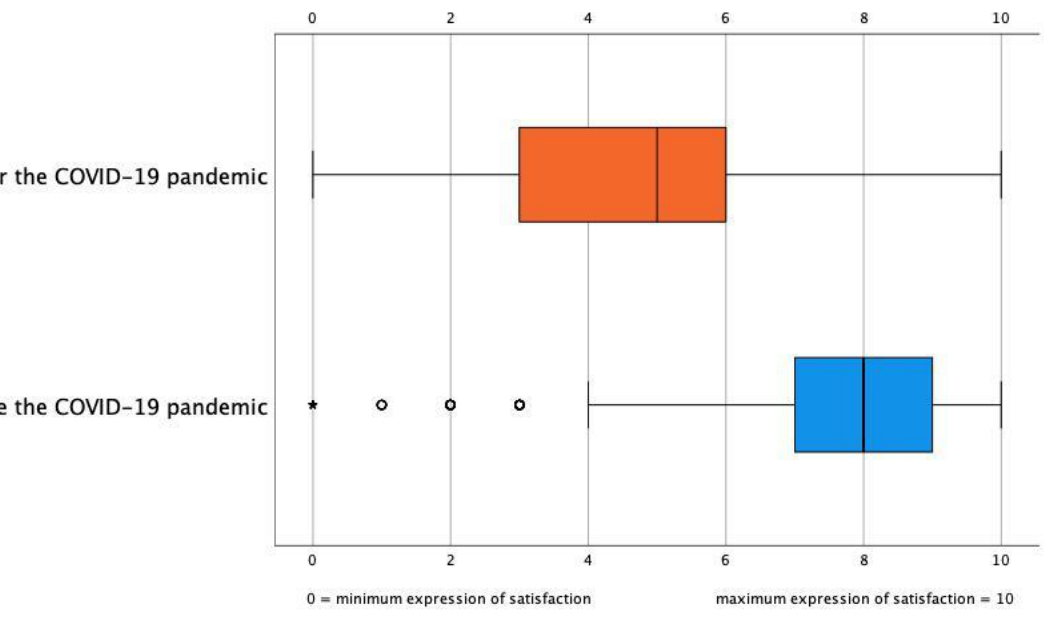
Figure 2. Well-being perception as a nurse before and at the COVID-19 pandemic first wave ( n = 1296).